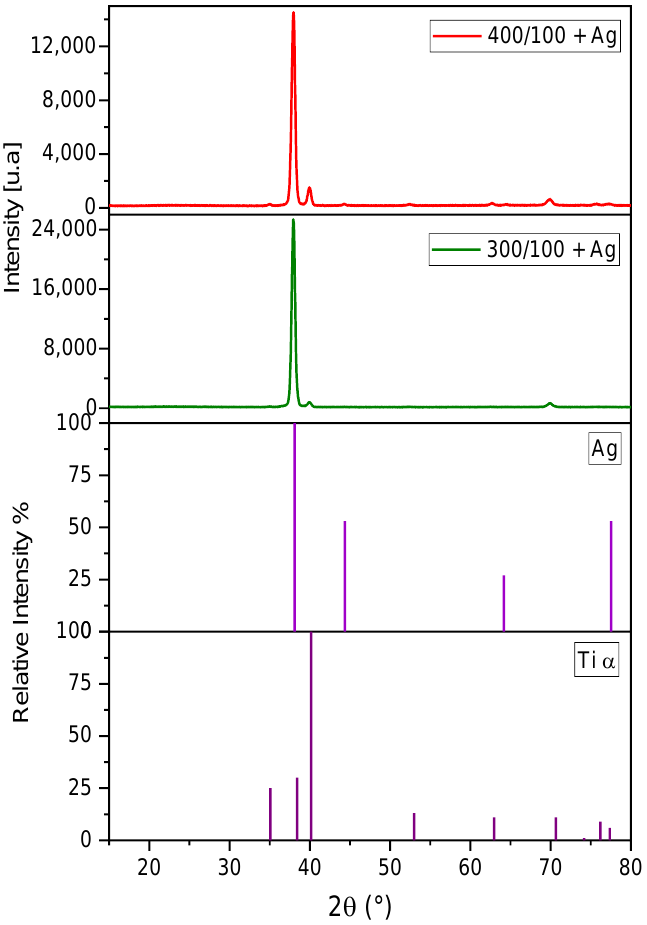
Figure 9. XRD diffractogram of the arc-PVD 400 Ar/100 O 2 and 300 Ar/100 O 2 TiO x coating with heat treatment and photo-reduction of Ag with patterns in relative intensity of Ag and Ti α.